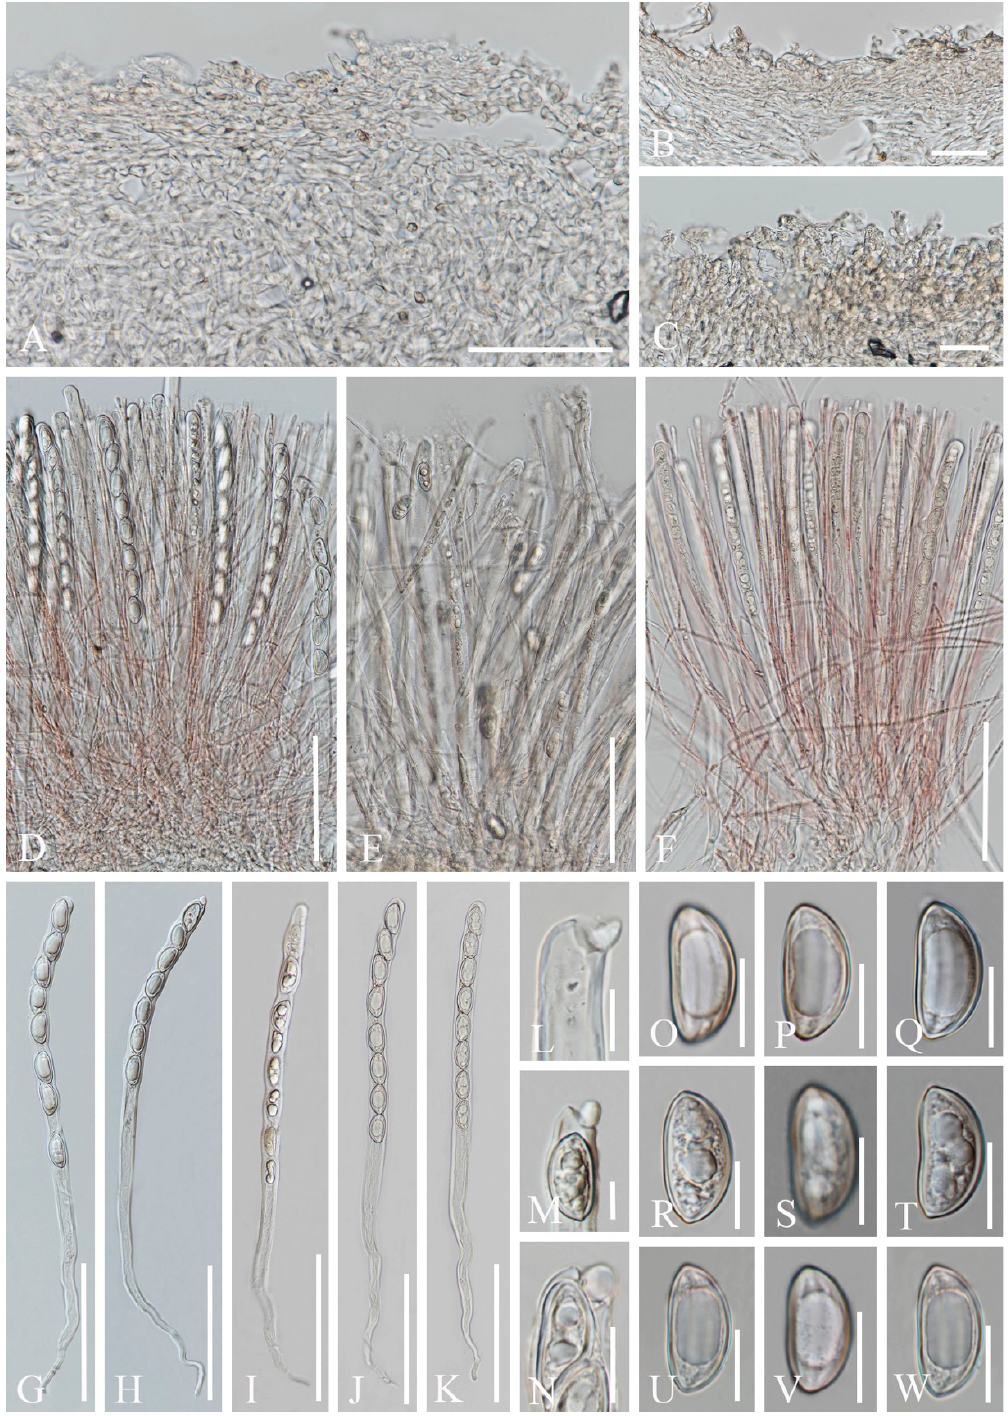
Figure 16. Sections of herbarium materials of Phillipsia gelatinosa . ( A , F , J , K , N , U – W ) MFLU 16 ‐ 2992. ( B , E , I , M , R – T ) MFLU 15 ‐ 2360. ( C , D , G , H , L , O – Q ) MFLU 16 ‐ 2956. ( A – C ) Vertical section of receptacle ectal excipulum. ( D – F ) Hymenium. ( G – K ) Asci and ascospores. ( L – N ) Apices of asci. ( O – W ) Ascospores. Scale bars ( A ) = 50 μ m; ( B , C ) = 30 μ m; ( D – K ) = 100 μ m; ( L – N ) = 10 μ m; ( O – W ) = 15 μ m.